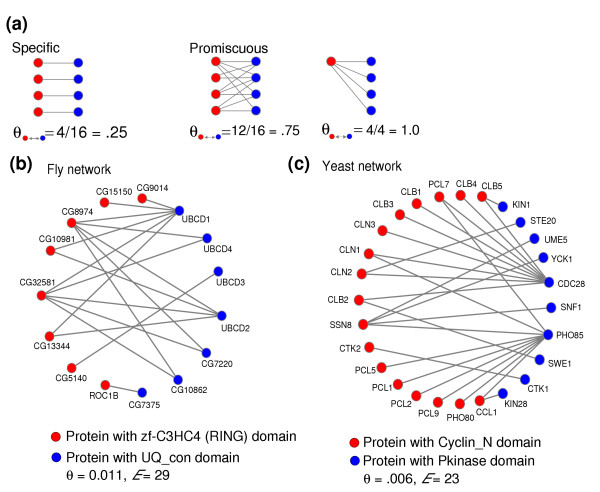
DPEA detects high-specificity domain interactions. (a) Interactions between domain families, such as the hypothetical red and blue domain families, whose members interact specifically are expected to have a low propensity, θ, because the number of interactions occurring between the domain families is a small fraction of the possible interactions (four out of 16 for two domain families of four members each). Conversely, domain interactions with a high θ will typically be between families whose members interact promiscuously. Because high-specificity domain interactions are of obvious interest to biologists, screening for domain interactions by their θ values fails to detect many important domain interactions. (b) Specific interactions of RING ubiquitin ligase domains [Pfam:PF00097, zf-C3HC4] with ubiquitin-conjugating enzymes [Pfam:PF00179, UQ_con] [32] in a fly protein network. The inferred domain interaction has a low θ (θ = 0.011, bottom 10%) and high E (E = 29, Table 1). This reflects the abundant evidence that the domains zf-C3HC4 and UQ_con interact, despite the low probability of interaction between any pair of these domains. (c) Specific interactions of Cyclin N-terminal domains [Pfam:PF00134, Cyclin_N] and protein kinase domains [Pfam:PF00069, Pkinase]. This interaction has a θ of 0.006, which is in the bottom 6% of θ for all domain pairs, suggesting the low propensity of interaction among members of these two domain families. However, the E score of 23 (the 13th highest score in the database) reveals the high degree of evidence for the Cyclin_N ↔ Pkinase interaction. These results show that DPEA identifies high-specificity domain interactions not detected by screening for the most probable domain interactions.